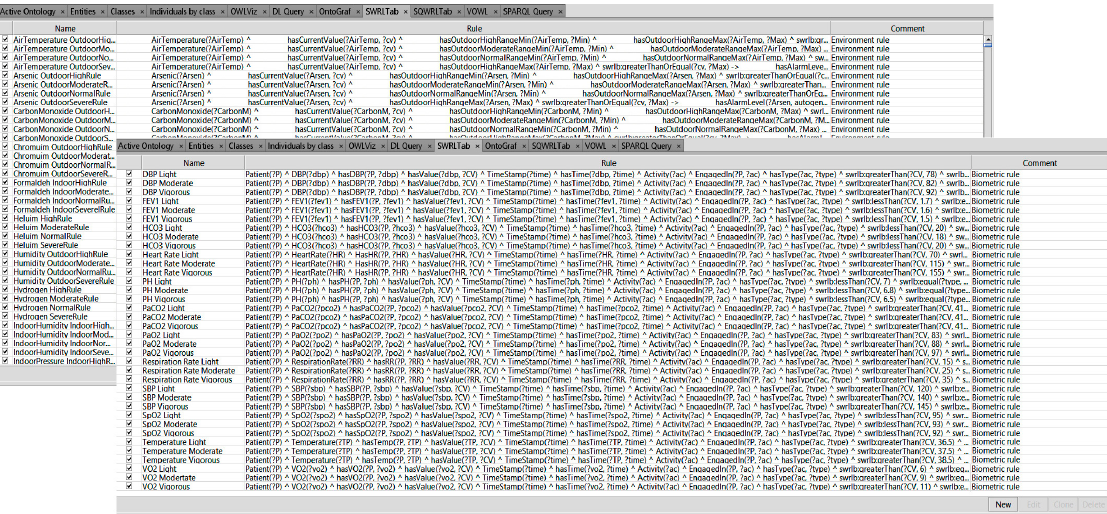
Figure 16. SWRL rules bases.